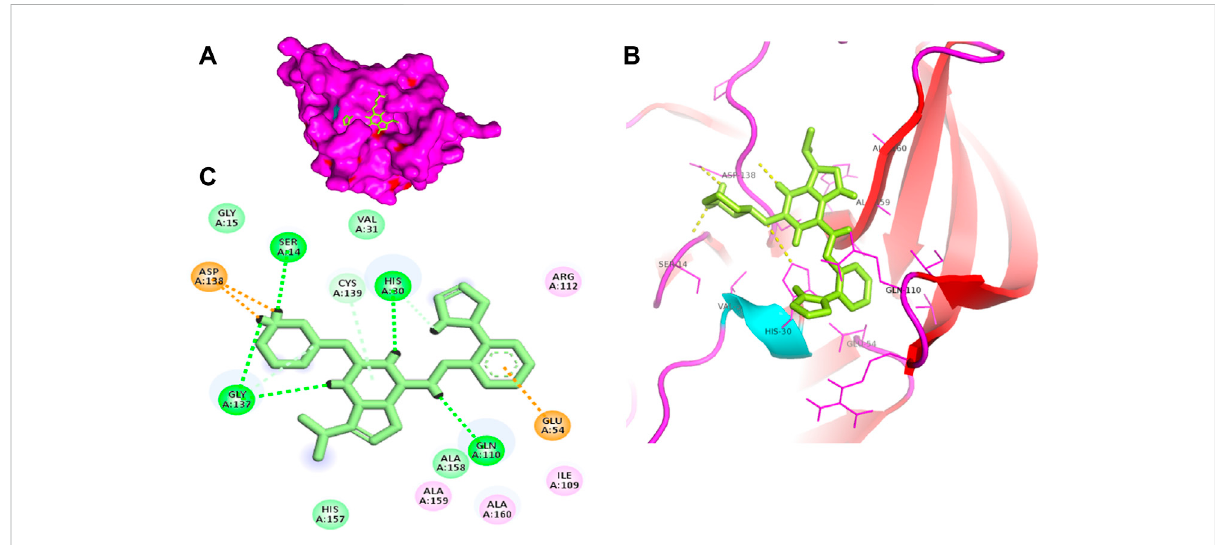
FIGURE 3 Surface view of LDC4297 in the 3CLP binding pocket (A) , 3D (B) and 2D (C) interacting residues of 3CLP with LDC4297.